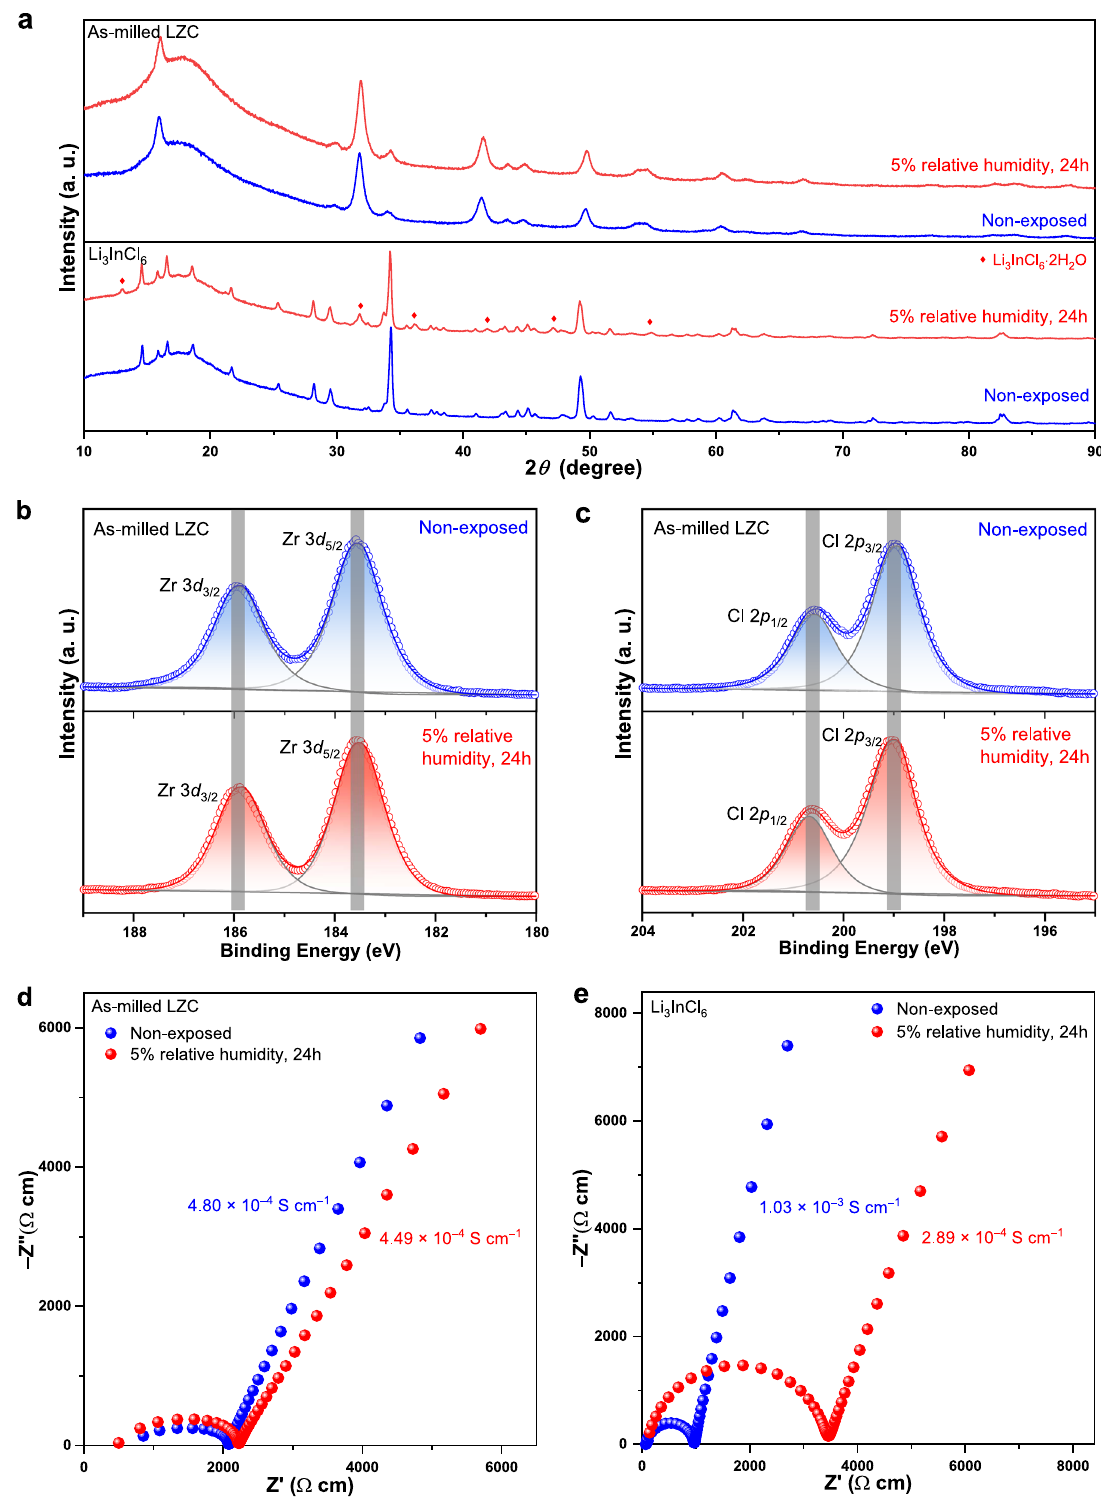
Fig. 7 Humidity tolerance of LZC. a XRD patterns of the as-milled LZC and Li 3 InCl 6 before and after being exposed to the atmosphere with 5% relative humidity. b , c Zr-3 d ( b ) and Cl-2 p ( c ) X-ray photoelectron spectra of the as-milled LZC before and after being exposed to the atmosphere with 5% relative humidity. d , e Nyquist plots of the as-milled LZC ( d ) and Li 3 InCl 6 ( e ) before and after being exposed to the atmosphere with 5% relative humidity. Note that the data here are not plotted in the unit of resistance, but in the unit of resistivity, i.e., the reciprocal of conductivity, which is calculated using the resistance and sample dimension. The diameters of the pellets used for measurement are all 10.8 mm. The pellet thicknesses are 1.12, 1.10, 1.50, and 1.00 mm for the non-exposed as-milled LZC, humidity-exposed as-milled LZC, non-exposed Li 3 InCl 6 , and humidity-exposed Li 3 InCl 6 ,